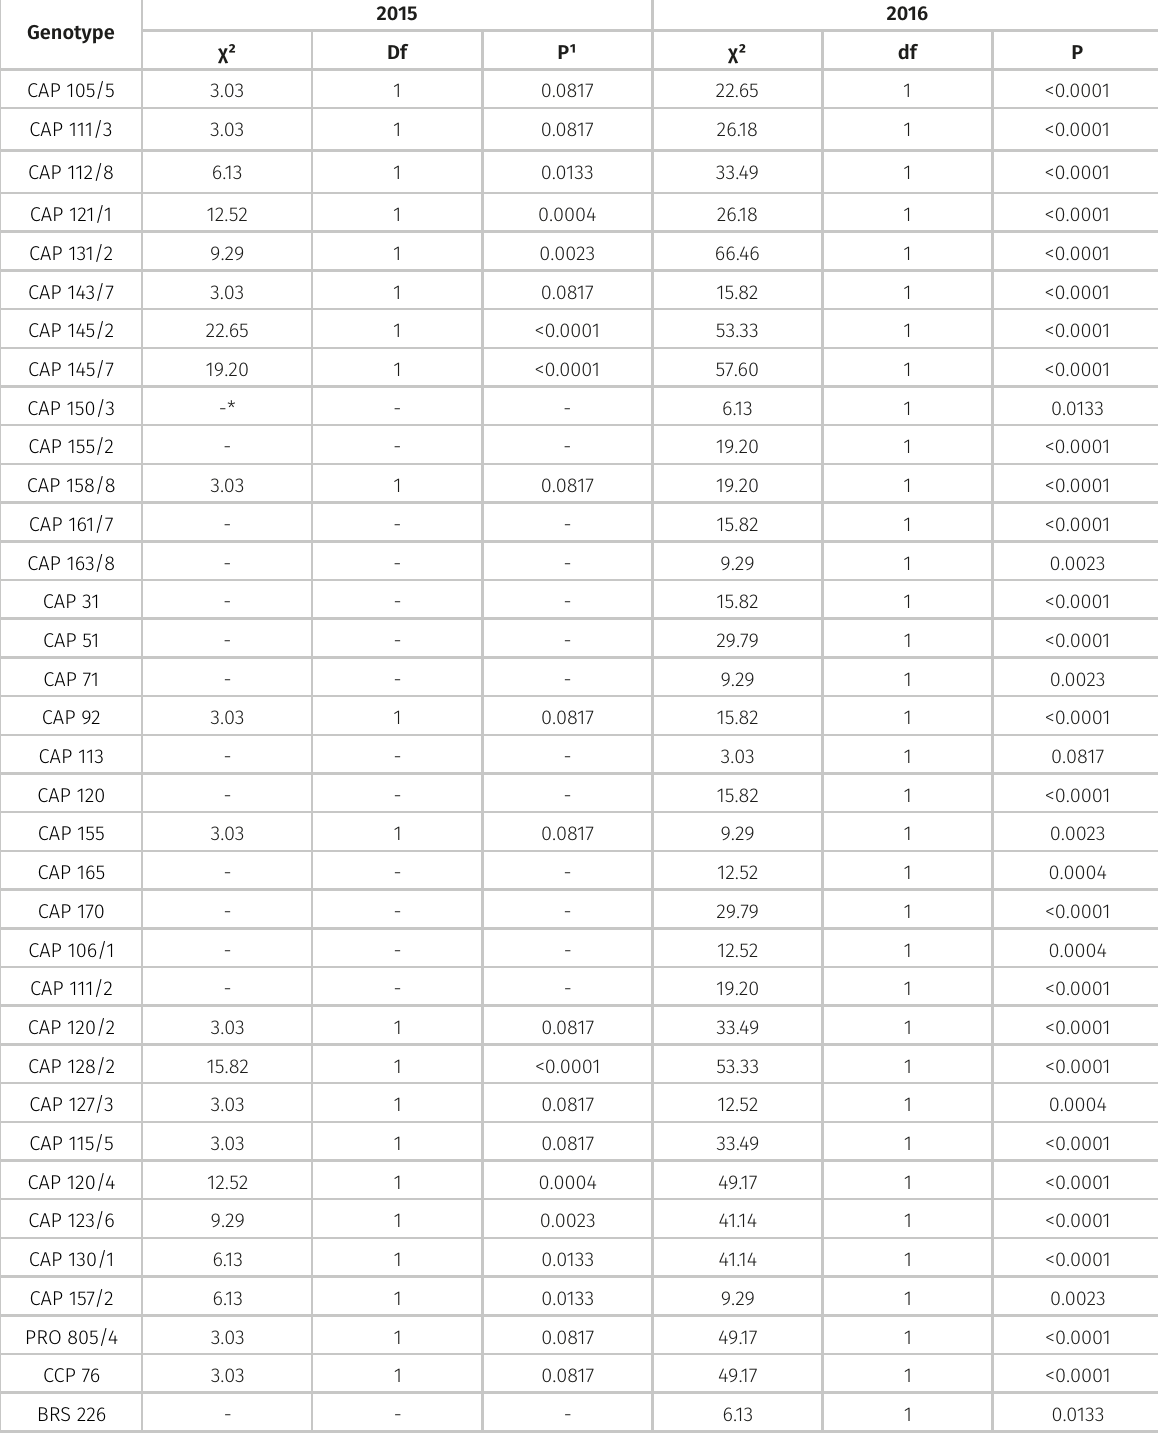
Table II. Association between H. fulvus and the flowering period of A. occidentale . ¹P < 0.05 = There was an association in the same sample interval (i.e., they were dependent), P > 0.05 = The species occurred in a different time interval (i.e., they were independent), *there was no occurrence of H. fulvus